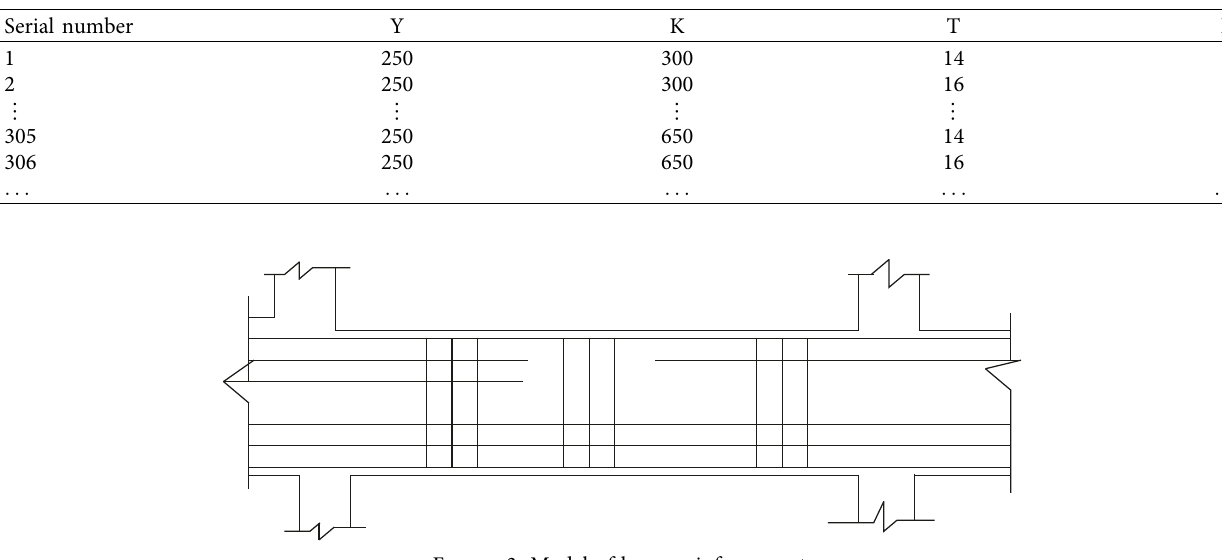
Figure 2: Building equipment energy conservation control system. Table 1: Beam selection database.